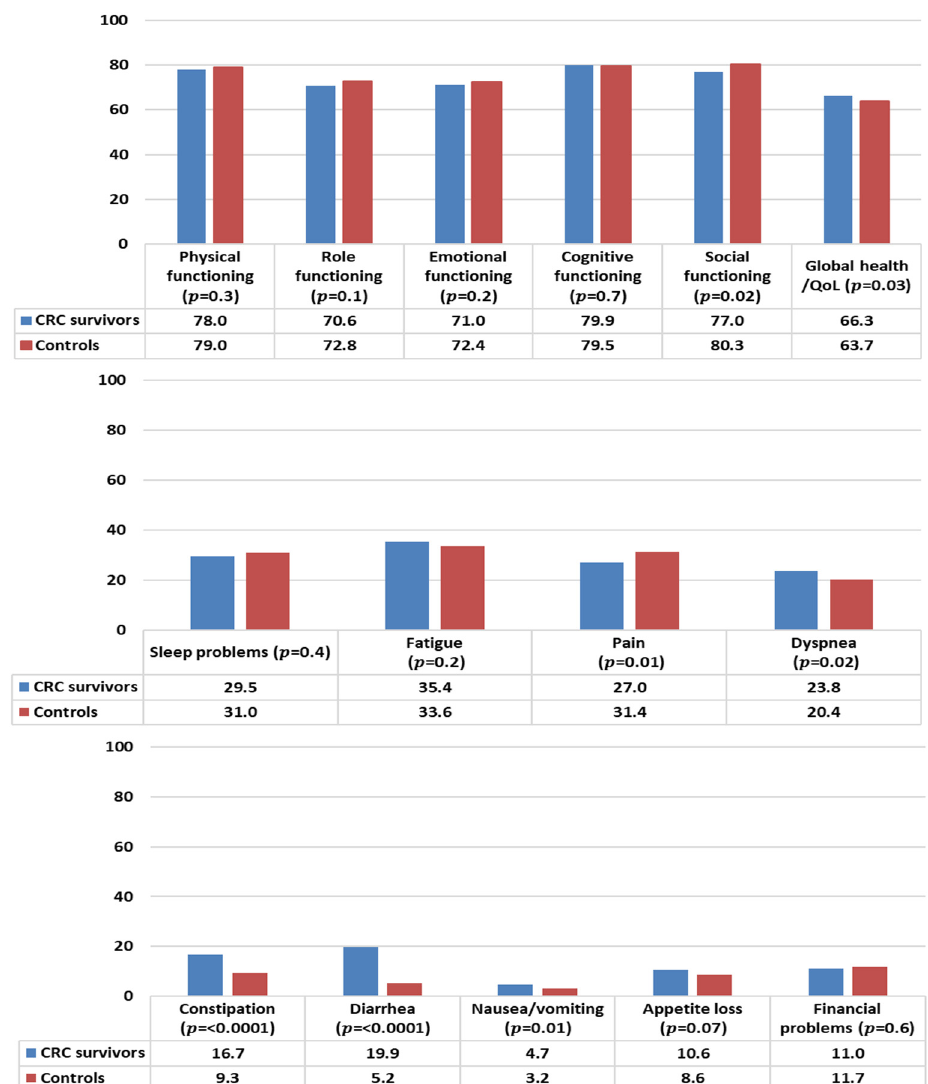
Figure 2. Mean EORTC QLQ-C30 scores of colorectal cancer (CRC) survivors and controls. Models are adjusted for age at survey, sex, and education. All results are based on 25 imputations of missing values.